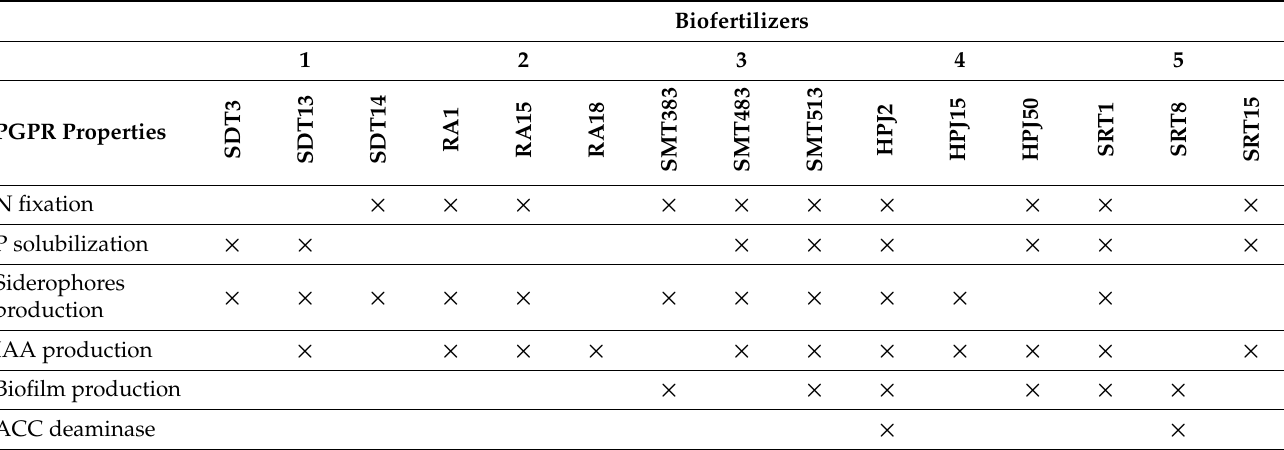
Table 1. Plant growth promoting rhizobacterial (PGPR) traits for the strains of biofertilizers used in this study (information obtained from Redondo-G ó mez et al.